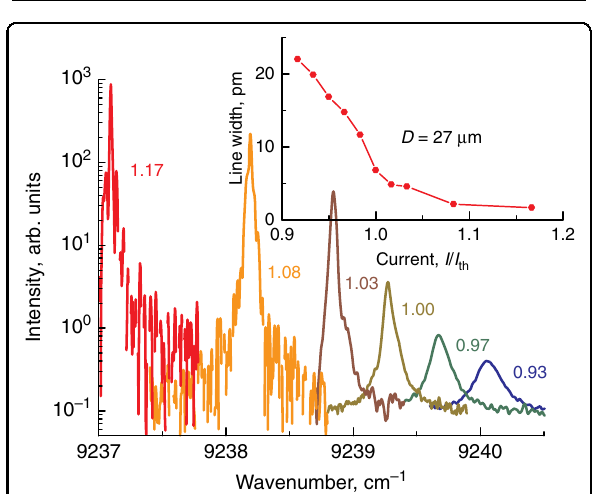
Fig. 8 High-resolution emission spectra. Main panel: high- resolution spectra of QWD-on-GaAs microdisk; numbers indicate the injection current normalized to the threshold current (I / I th ). Inset: linewidth (FWHM) against normalized injection current